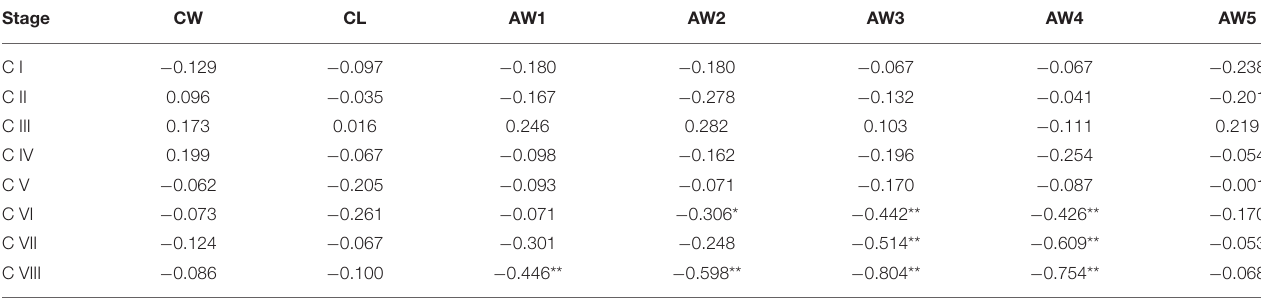
TABLE 3 | Correlation coefficients between morphological traits and sex at the different development stages. Stage